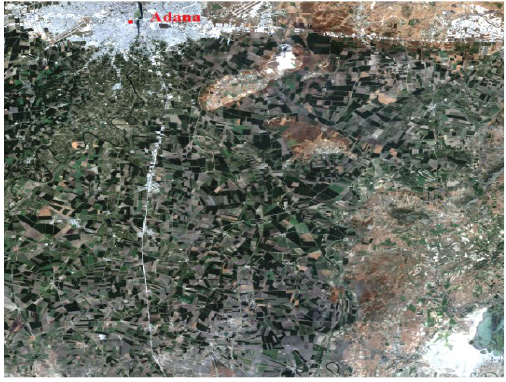
Figure 2. Study Area (South of